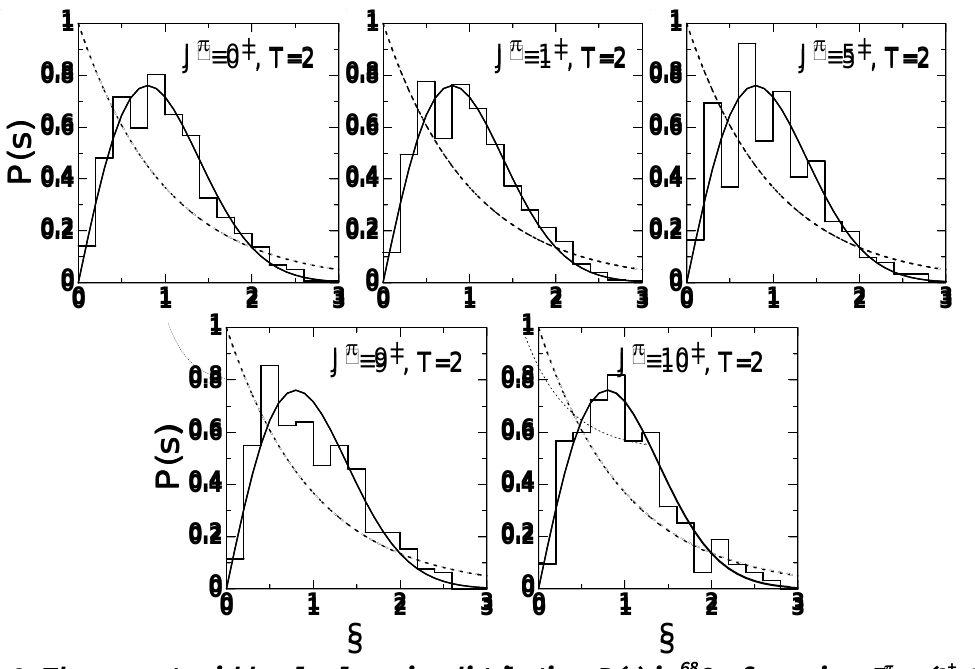
Fig. 2: The nearest neighbor level spacing distributions P(s) in 68 Ge for various J π = (0 + ,1 + , 5 + , 9 + , and 10 + ) states. The GOE (solid line) and Poisson distributions (dashed